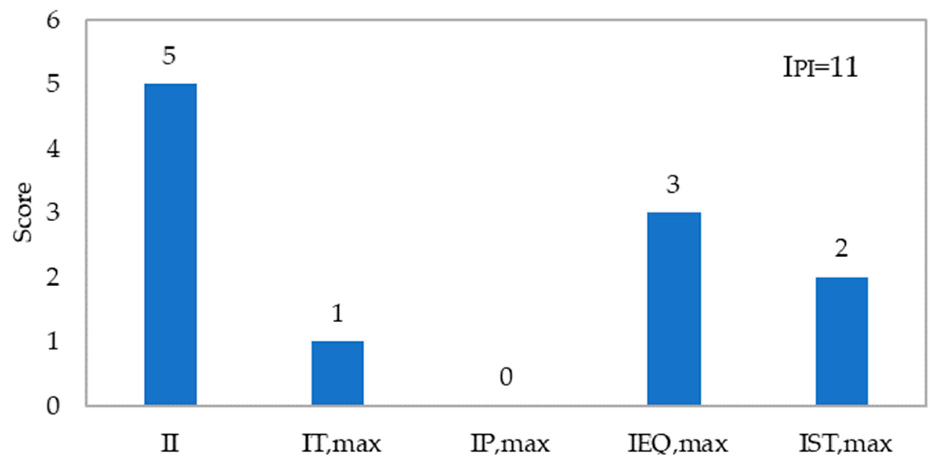
Figure 5. Subindices and total score for chemical inherent safety index.